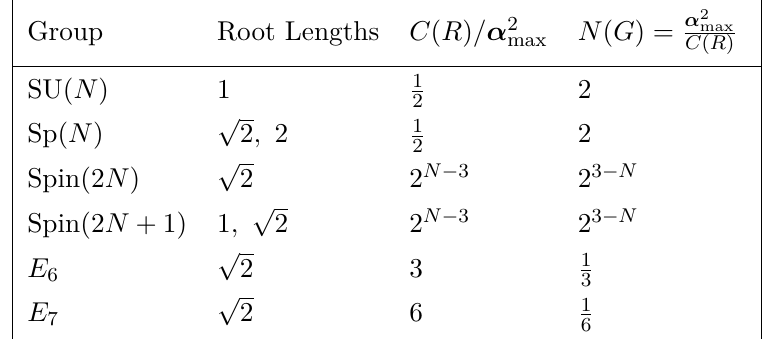
Table 4 . Groups with their root lengths, “convenient” representation Dynkin indices C ( R ) , as well as the normalization N ( G ) of the topological charge